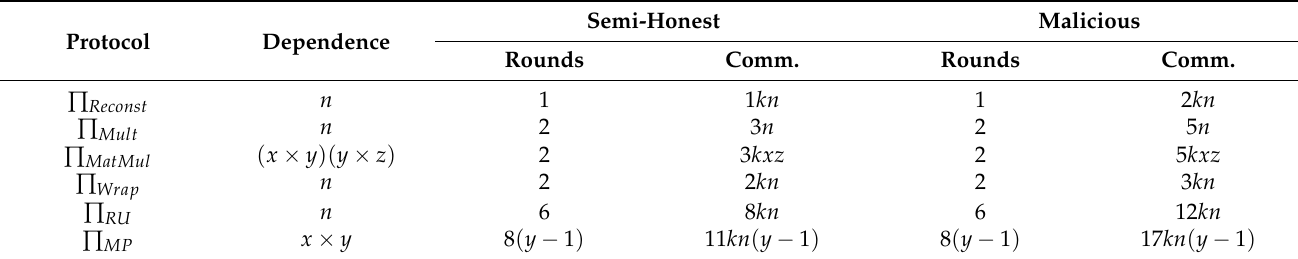
Table 1. Theoretical overheads of protocols.